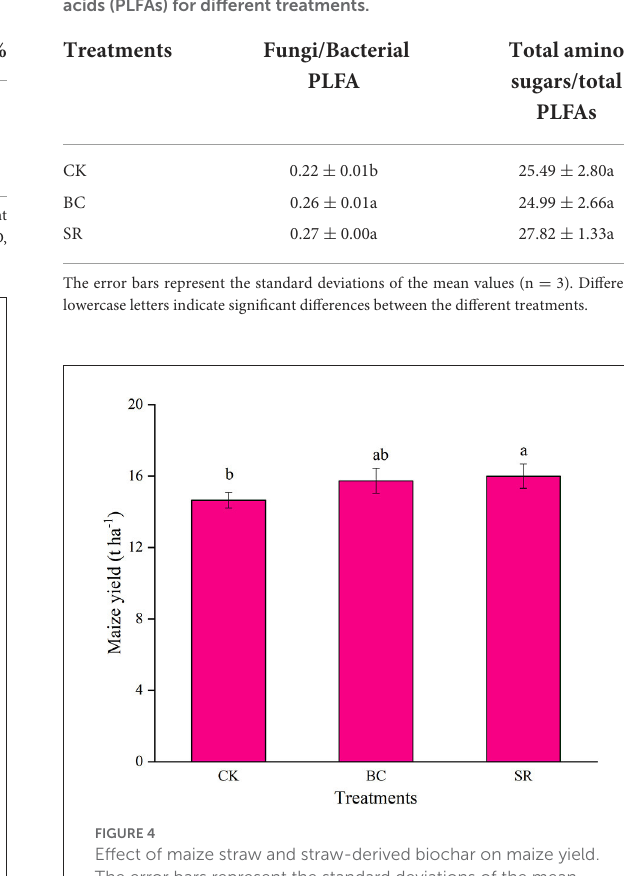
TABLE 6 Effect of maize straw and straw-derived biochar on soil aggregate stability in 2021.